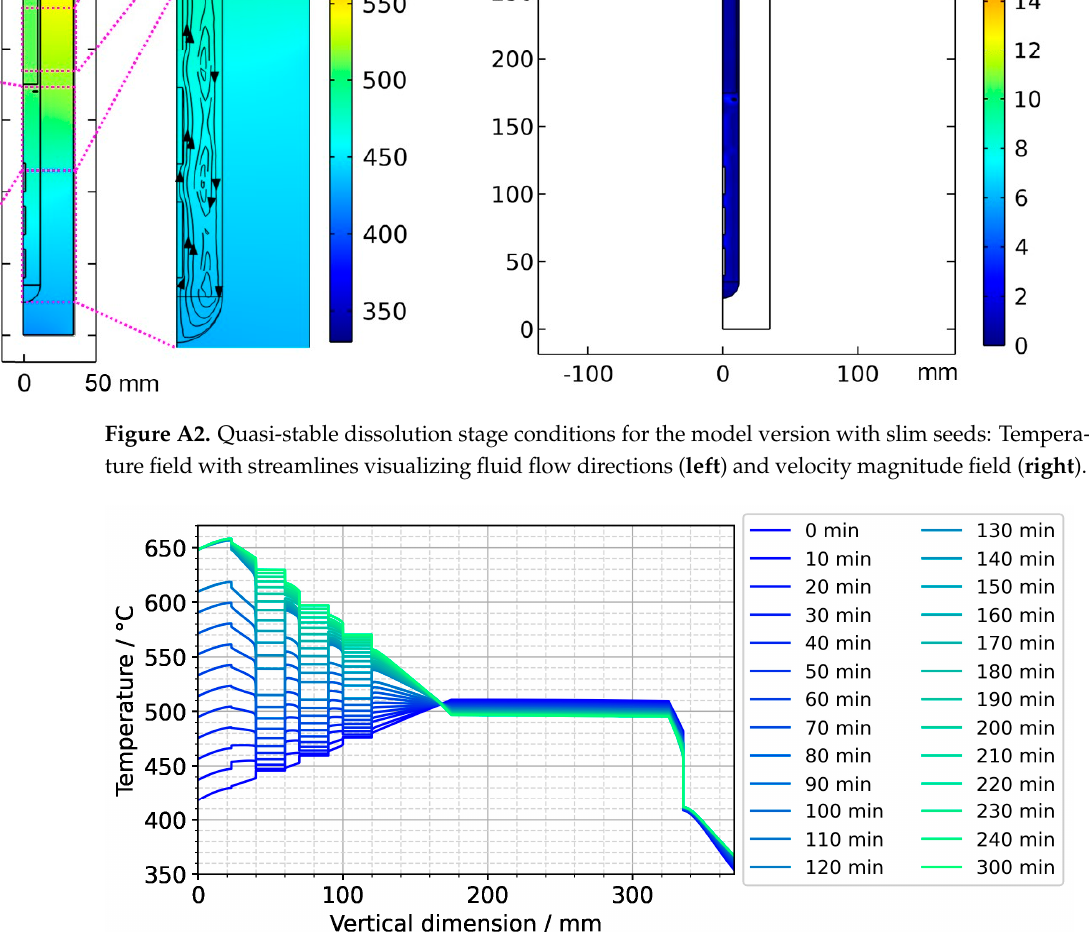
Figure A3. Temperature distribution along the centerline for the entire set temperature inversion process. The quasi-stable conditions of etch-back stage are present at the time 0 min. The time 120 min represents the moment at which set temperatures have reached their values for growth stage. The time 300 min corresponds to quasi-stable conditions of growth stage.